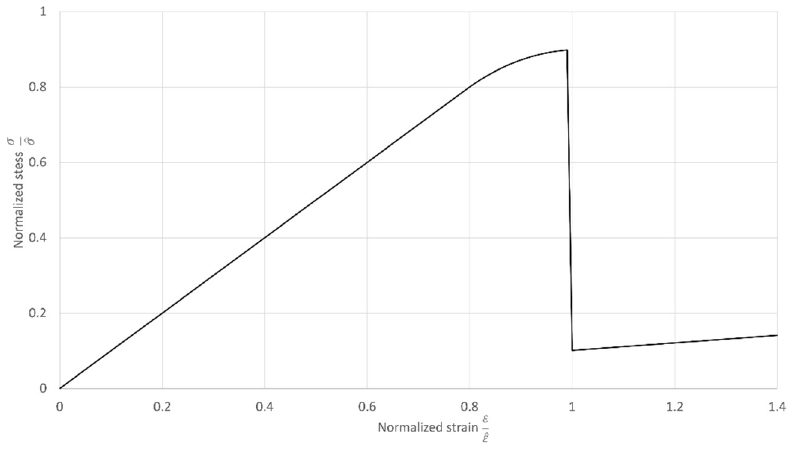
Figure 9. Schematic of a stress/strain curve for a typical fiber or matrix material normalized to the failure stress/strain.